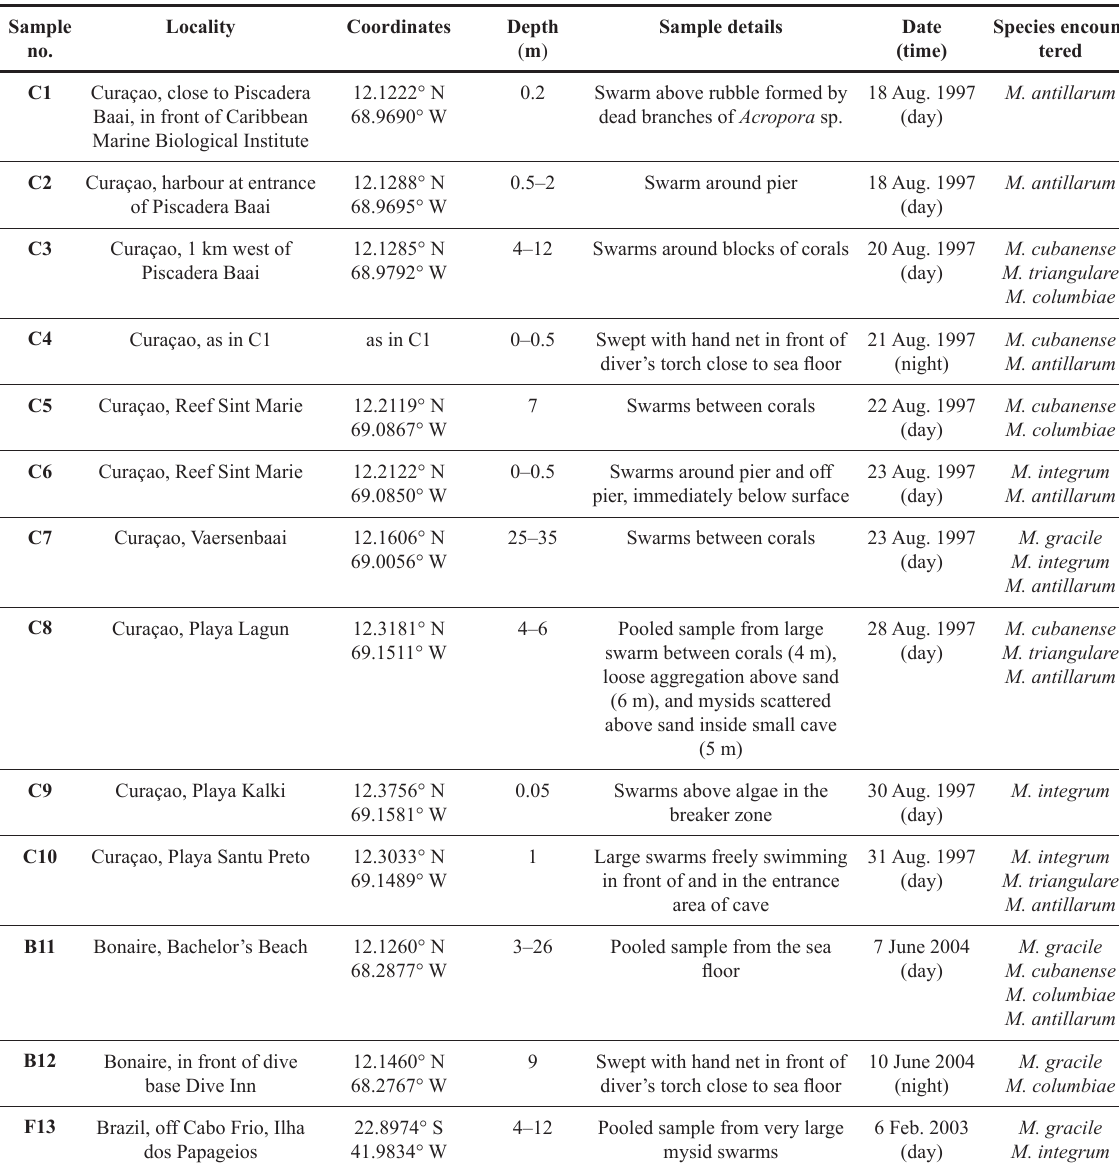
Table 1. Sampling data of species of Mysidium Dana, 1852 in euhaline coastal waters of Curaçao, Bonaire and